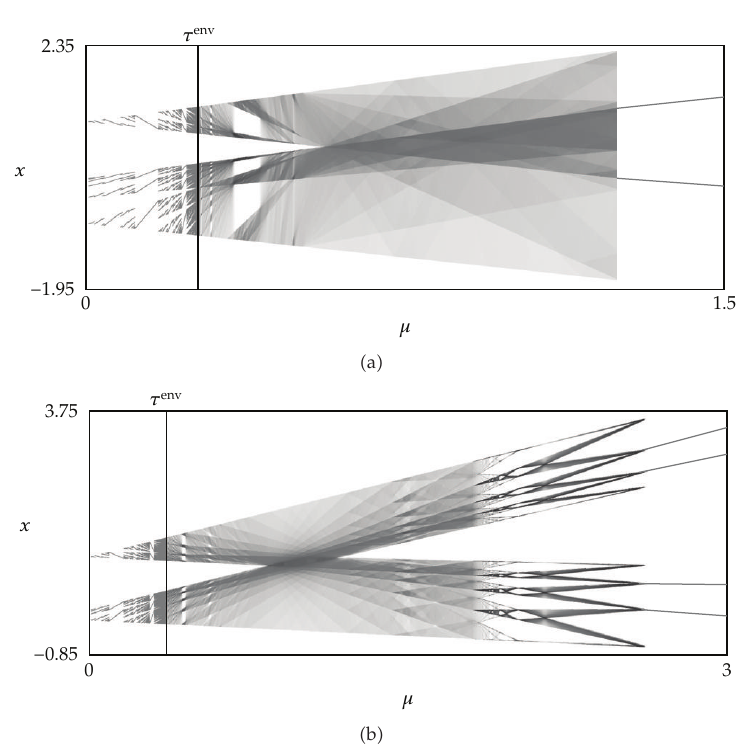
Figure 3: Numerically calculated bifurcation diagrams for a (cid:6) − 0 . 42, b (cid:6) − 1 . 8, μ (cid:6) 0 ··· 1 . 5 (cid:7) a (cid:8) and a (cid:6) − 0 . 42, b (cid:6) − 1 . 195, μ (cid:6) 0 ··· 3 . 0 (cid:7) b (cid:8) . Both show similar structures in the left part, while they are significantly di ff erent in the right part. The location of these scans in the (cid:7) b,μ (cid:8) -plane is shown in Figure 2 (cid:7) c (cid:8) with dashed lines. The line A corresponds to (cid:7) a (cid:8) and the line C to (cid:7) b (cid:8)